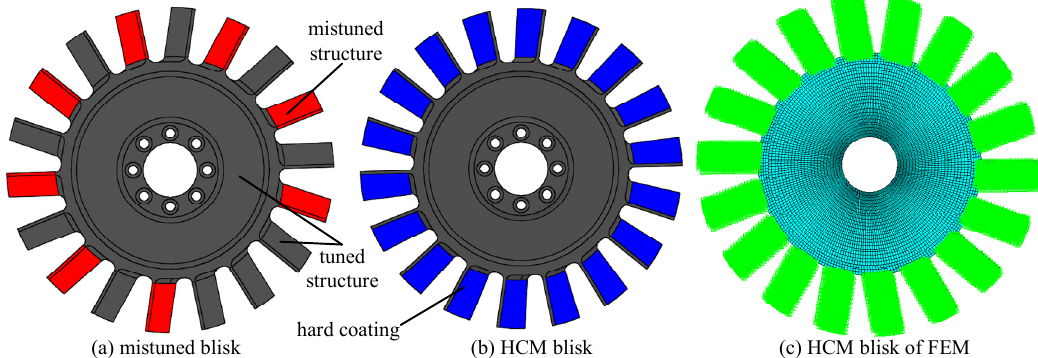
Figure 2. Solid model of ( a ) the mistuned blisk, ( b ) the hard coated mistuned (HCM) blisk and ( c ) FEM of the hard coated mistuned (HCM) blisk.